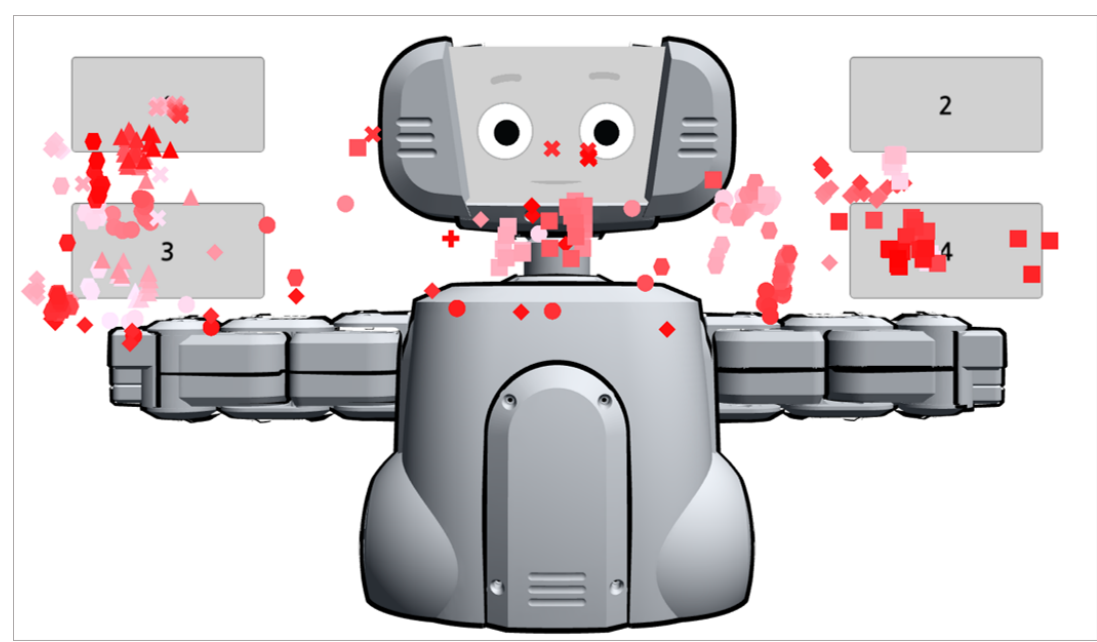
Figure 6. Gaze distributions of selected participants in the OC group: different symbols represent different participants, with increasing color saturation over time. The gaze targets were scattered as they failed to recognize the hint toward choice no. 3.